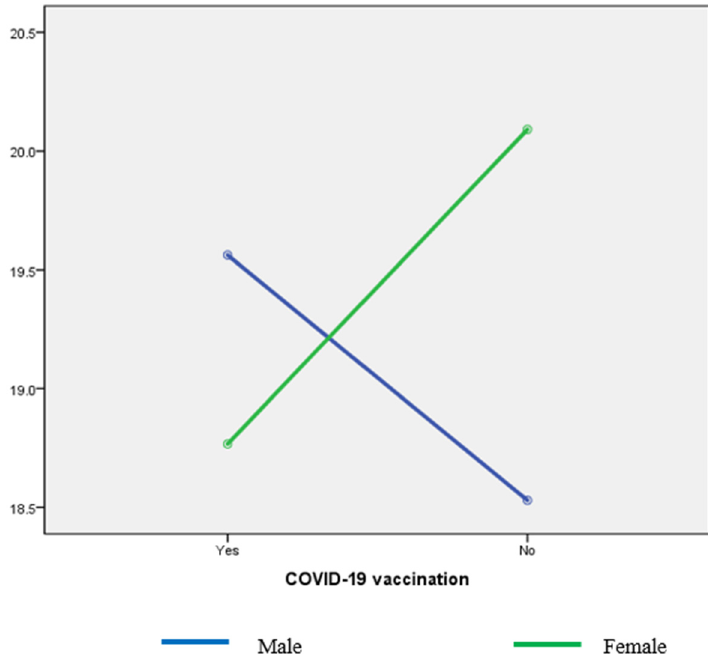
Figure 2. Resilience by gender and COVID-19 vaccination status. The mean SBM (burnout) scores were 19.5 (SD = 9.2) and 20.8 (SD = 8.7) for the male and female students (t(427) = 1.491; p = 0.137). The average burnout value score for all students was 20.1 (SD = 9.0). Two-way ANOVA showed that burnout was not associated with gender and COVID-19 vaccination: F(1,425) = 0.001; p = 0.974. Only 10.0% of the Indian students surveyed ( n = 44) reported substance use in the previous month (e.g., cigarettes, alcohol, cannabis and prescription drugs such as pain relievers and sedatives). Of this group, 31.8% ( n = 14) reported an increase in substance use associated with COVID-19.